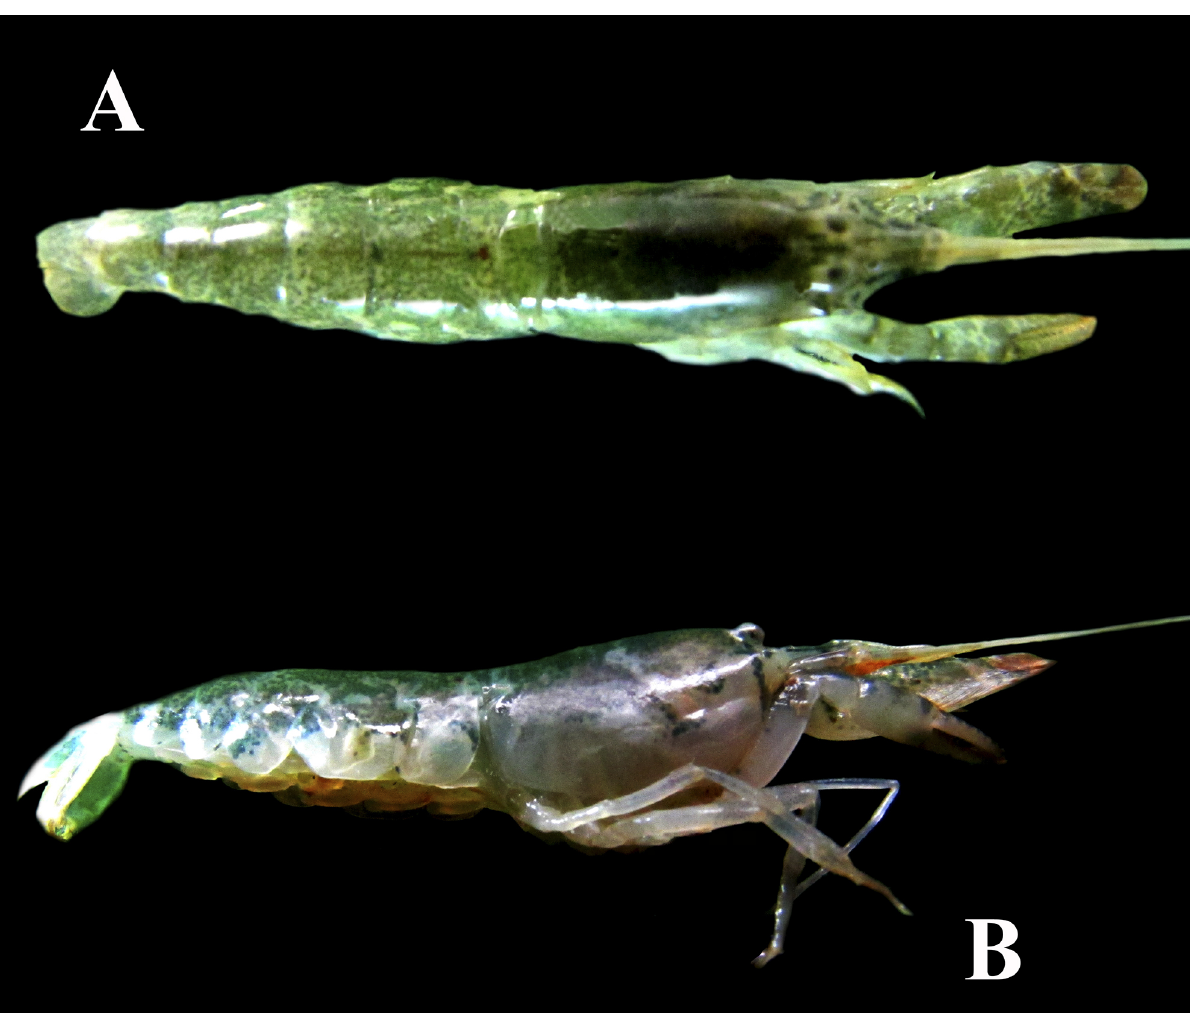
Figure 2. Alpheus platycheirus Boone, 1927, ovigerous female. A , Dorsal view; B , lateral view. CL: 7.6